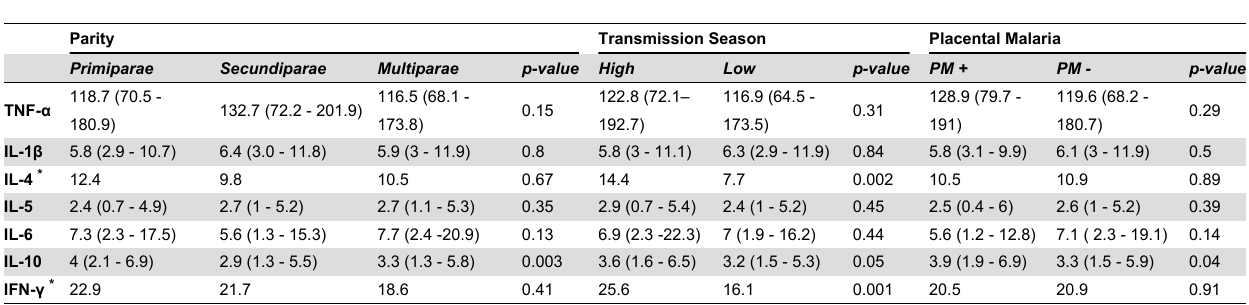
Table 2. Cord cytokine levels stratified by parity, transmission season and placental malaria status (Median [Q1-Q3]).